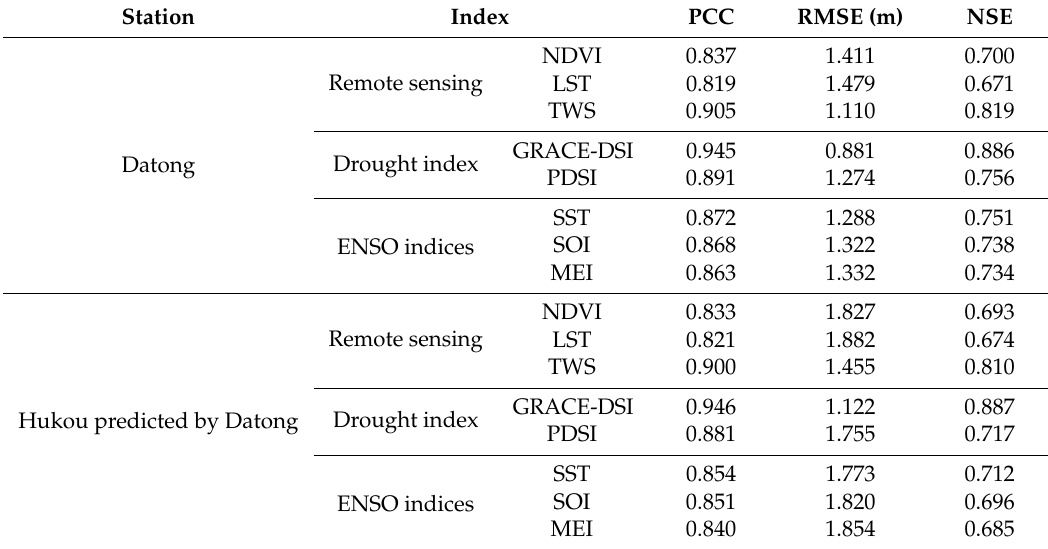
Table 1. Internal and external assessment of the reconstructed water levels from various indices at Datong station and the predicted water level at the location of Hukou station, respectively, against the observed water levels. In the lower part, the constructed relationship between Datong time series data and various indices is used to predict the water level time series at the location of Hukou station along the Yangtze River.